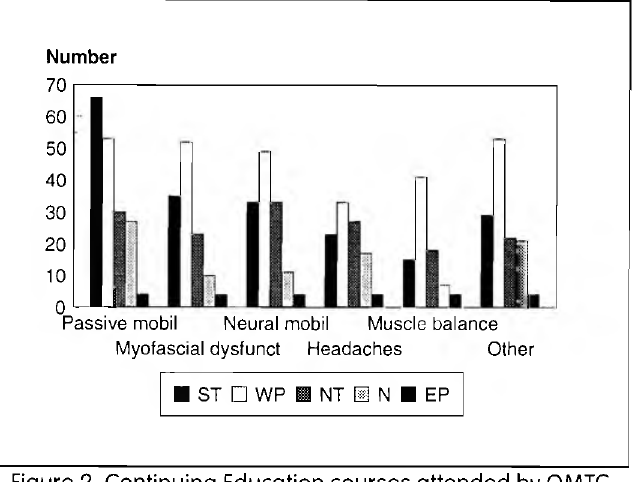
Figure 2. Continuing Education courses attended by OMTG